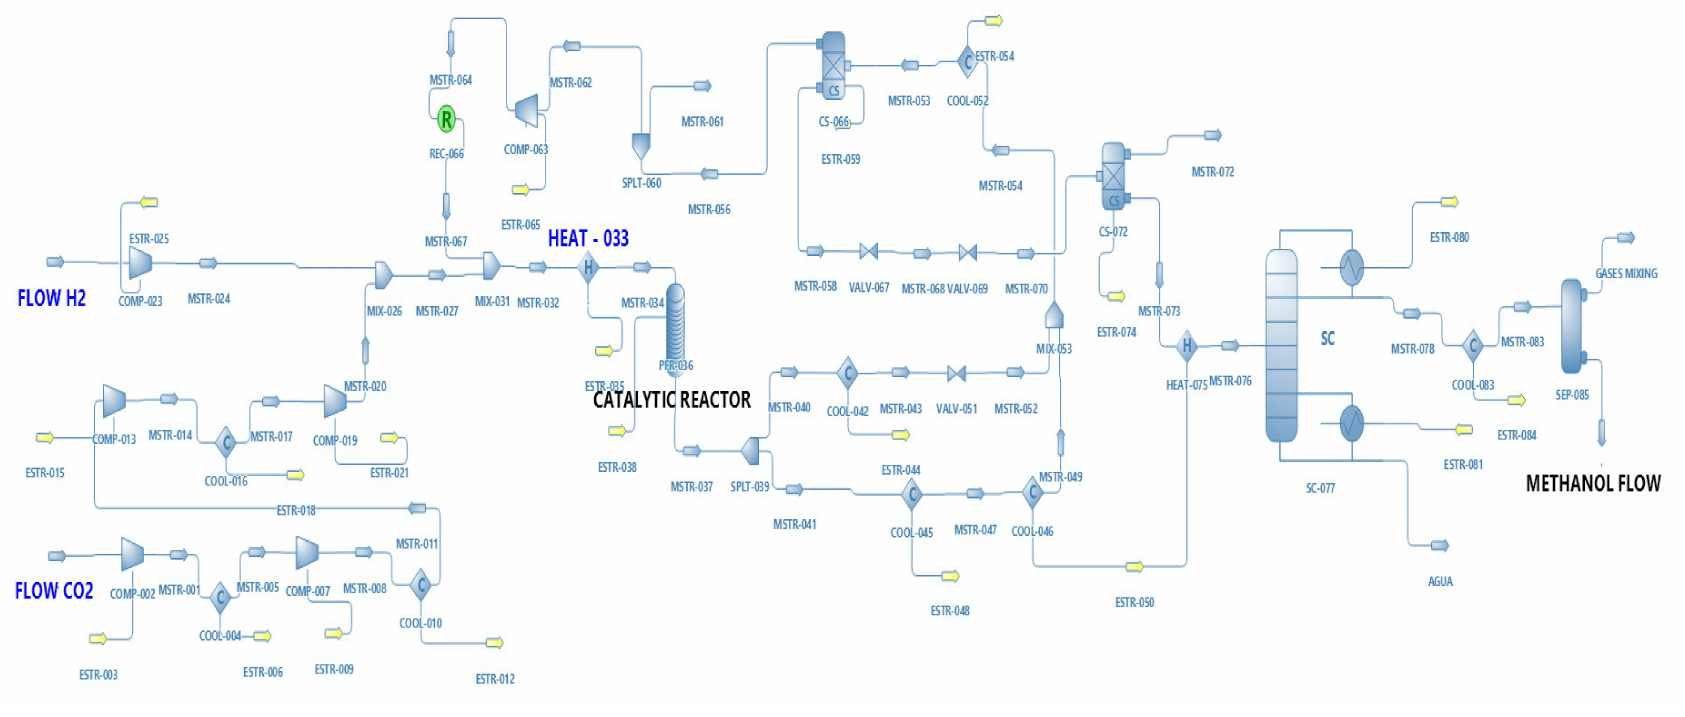
Figure 1. Flowsheet methanol